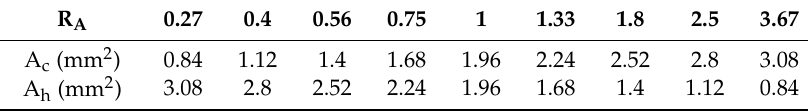
Table 4. Various cross-sectional area ratio of the cold side to the hot